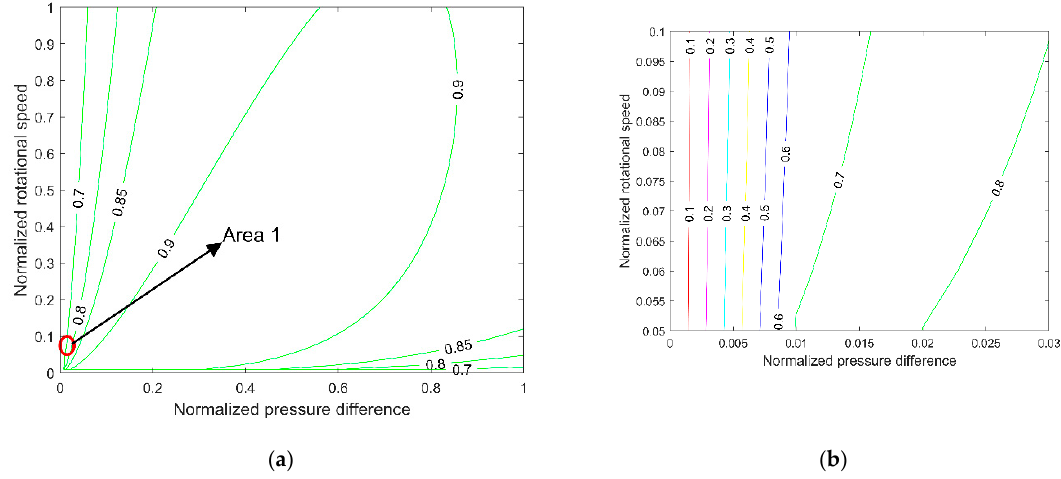
Figure 9. Efficiency contours of the pump motor (PM) as a function of the normalized pressure difference and rotational speed in pumping mode: ( a ) the whole view and ( b ) enlarged view of area 1.